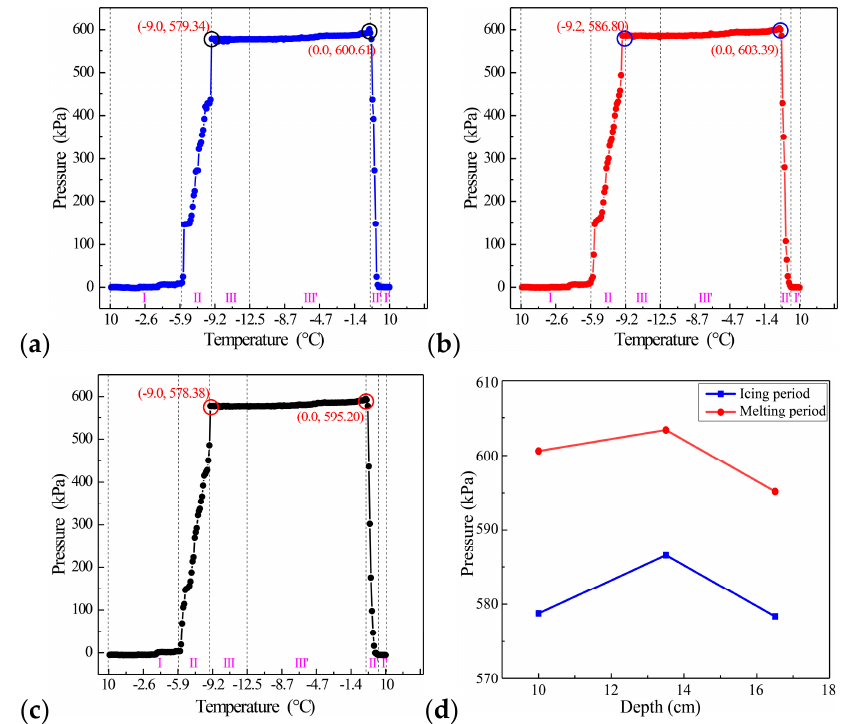
Figure 12. The curve of static ice pressure at di ff erent depths; ( a ) sidewall static ice pressure-temperature curve when the depth of the sensor is 10 cm; ( b ) sidewall static ice pressure-temperature curve when the depth of the sensor is 13.5 cm; ( c ) sidewall static ice pressure-temperature curve when the depth of the sensor is 16.5 cm; ( d ) variation curve of static ice pressure along with the depth during the ice growth and melting